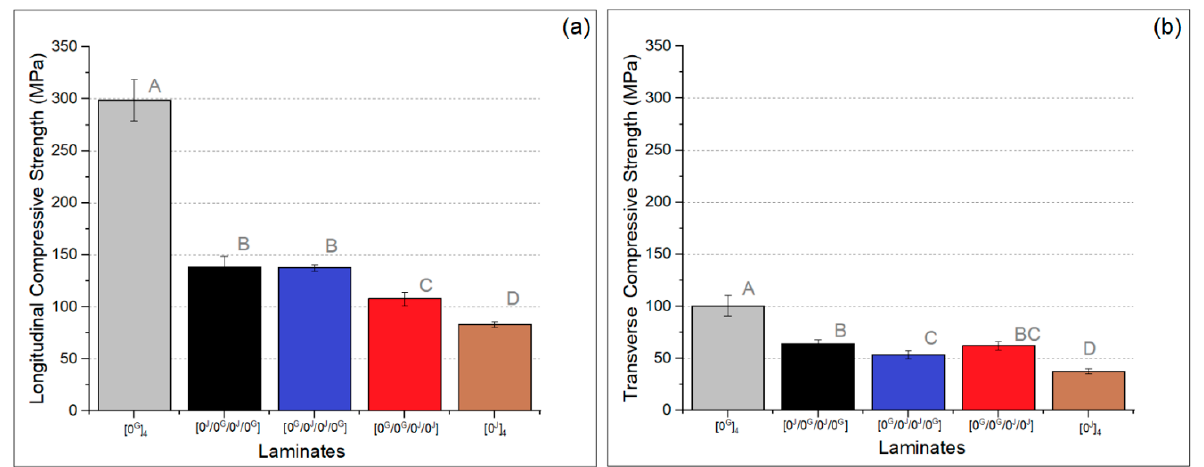
Figure 8. Longitudinal ( a ) and transverse ( b ) compressive strength of the laminates (letters represent the results of the Tukey’s test).